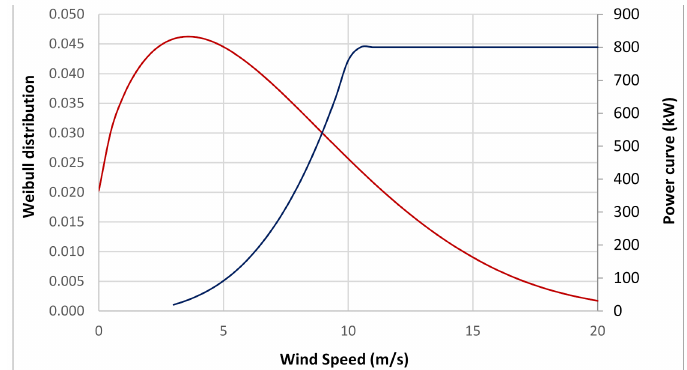
Figure 5. Energy production estimation of Ati, Chad.